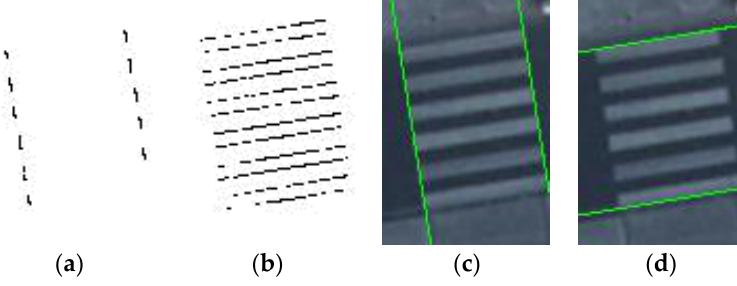
Figure 11. Boundary line detection. ( a ) Depicts the edge lines of stripe widths detected by HT; ( b ) Depicts the edge lines of stripe lengths detected by HT; ( c , d ) are the boundary lines of a zebra crossing.